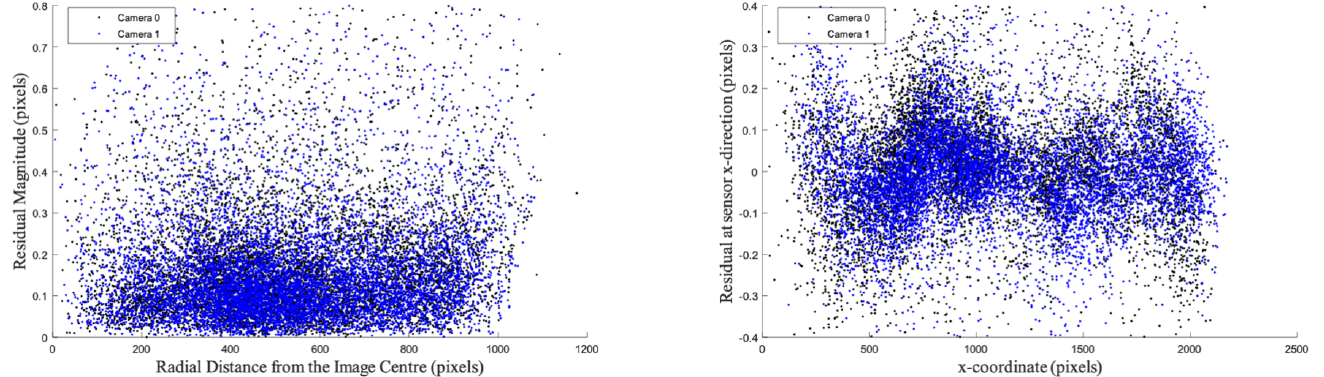
Figure 13. Unmodelled systematic errors in the residuals when using the manufacturer’s calibration model and parameters. ( Left ) The magnitude of the residuals. ( Right ) The x-component of the residuals.